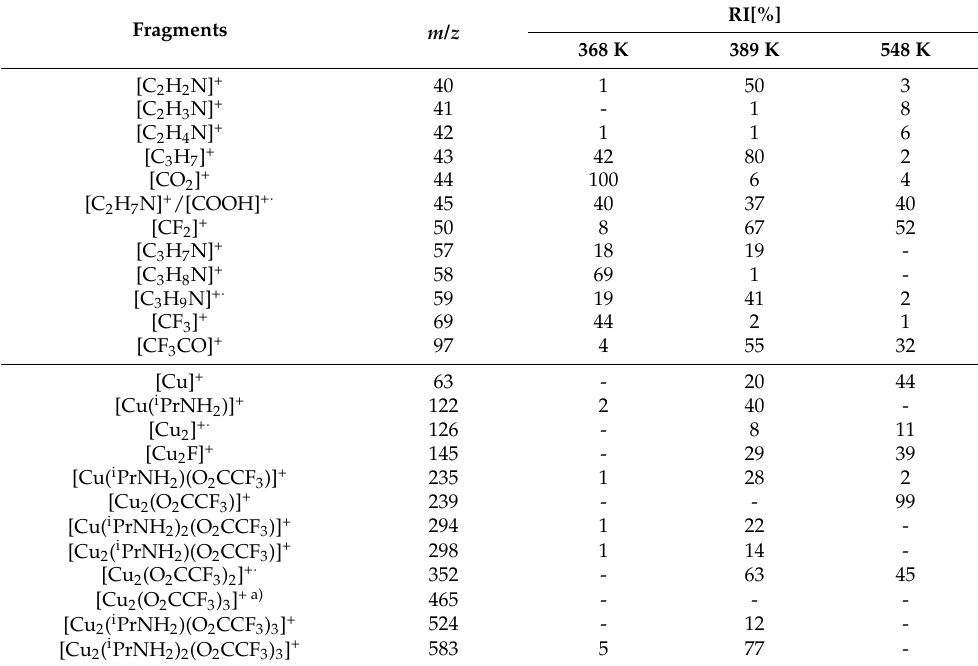
Similar ions were observed for the [Cu 2 ( i PrNH 2 ) 2 ( µ -O 2 CR f ) 4 ] complexes ( 7 – 10 ) (Table 3 and Tables S6–S8), a molecular ion characteristic for isopropylamine was recorded [C 3 H 9 N] + (59 m/z ) and achieved the highest intensity RI = 46% for ( 8 ) at 404 K, for other compounds intensity of this ion were in the range of 16–41% for ( 7, 9, 10 ) at 372–389 K. The highest intensity of a metallated fragment with isopropylamine molecule [Cu( i PrNH 2 )] + (122 m/z ) were observed for ( 8 ) RI = 53% at 404 K, while for other compounds ( 7 ) RI = 40% at 389 K and ( 9 ) RI = 25% at 372 K. Table 3. Mass spectrometry EI MS data of [Cu 2 ( i PrNH 2 ) 2 ( µ -O 2 CCF 3 ) 4 ] ( 7 ).